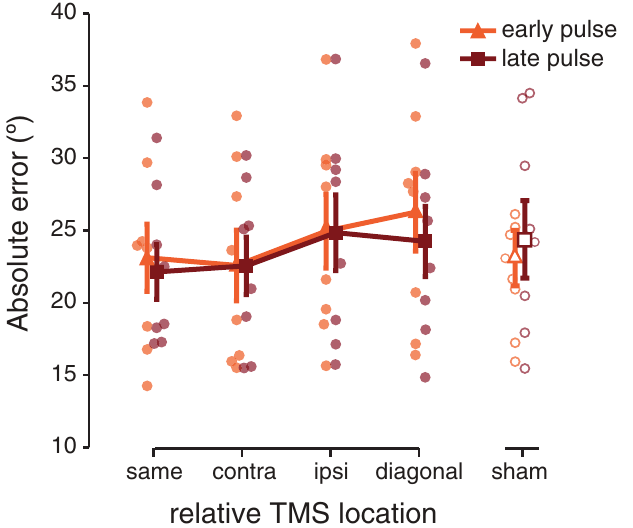
Fig 2. Absolute error relative the TMS location. When a memory item was cued at the same location as targeted by the TMS pulses, the absoluteresponseerror was marginallysmaller than when a memory item was probeddiagonallyto the pulses. This indicatedbetter performance when the memory item at the TMS location was cued (comparedto the item diagonal to TMS). Early pulses resulted in marginally worse performance comparedto late pulses, irrespective of the cued visual field location. Sham data (unfilledorange and red symbols) are showncollapsedacross all locations,separately for early and late sham pulses. A separatestatistical test showedthat the time point at which audiblesham clicks were delivereddid not impact behavior. Transparentdots indicate individual participantdata, error bars depict ± 1 SEM.